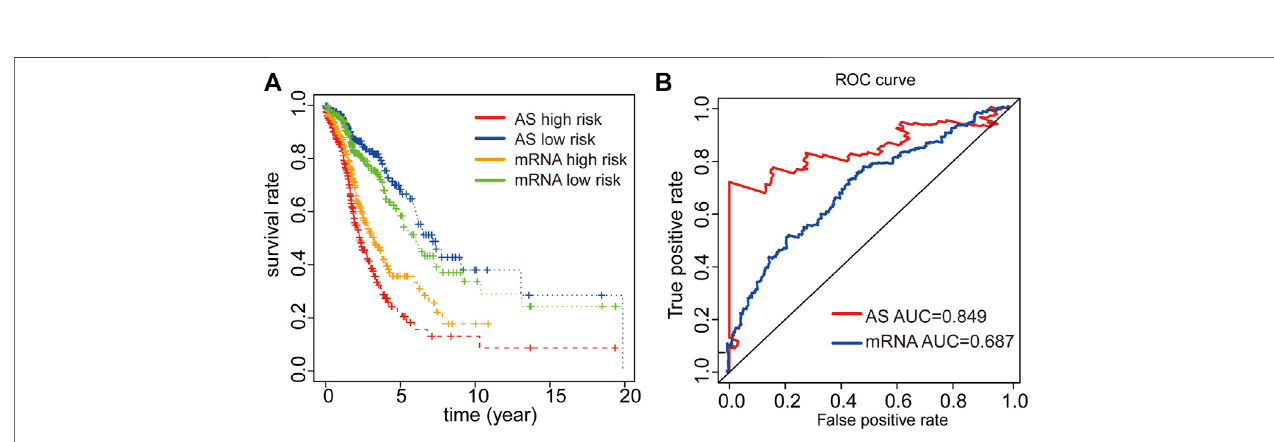
FIGURE5| ComparisonofKaplan-Meierandtime-dependentROCanalysisofourASsignaturewithmRNAsignature. (A) ComparisonofKaplan-Meieranalysisof our AS signature and mRNA signature. (B) Comparison of ROC analysis of the sensitivity and speci fi city of our AS signature and mRNA signature.